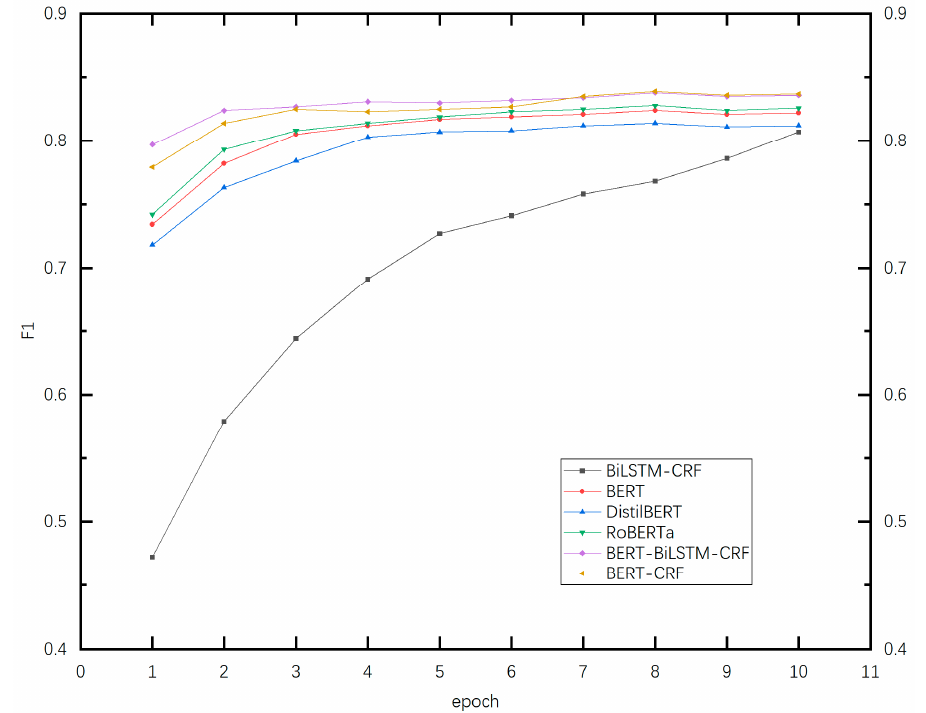
Figure 6. Changes in F1 score with increasing epochs.